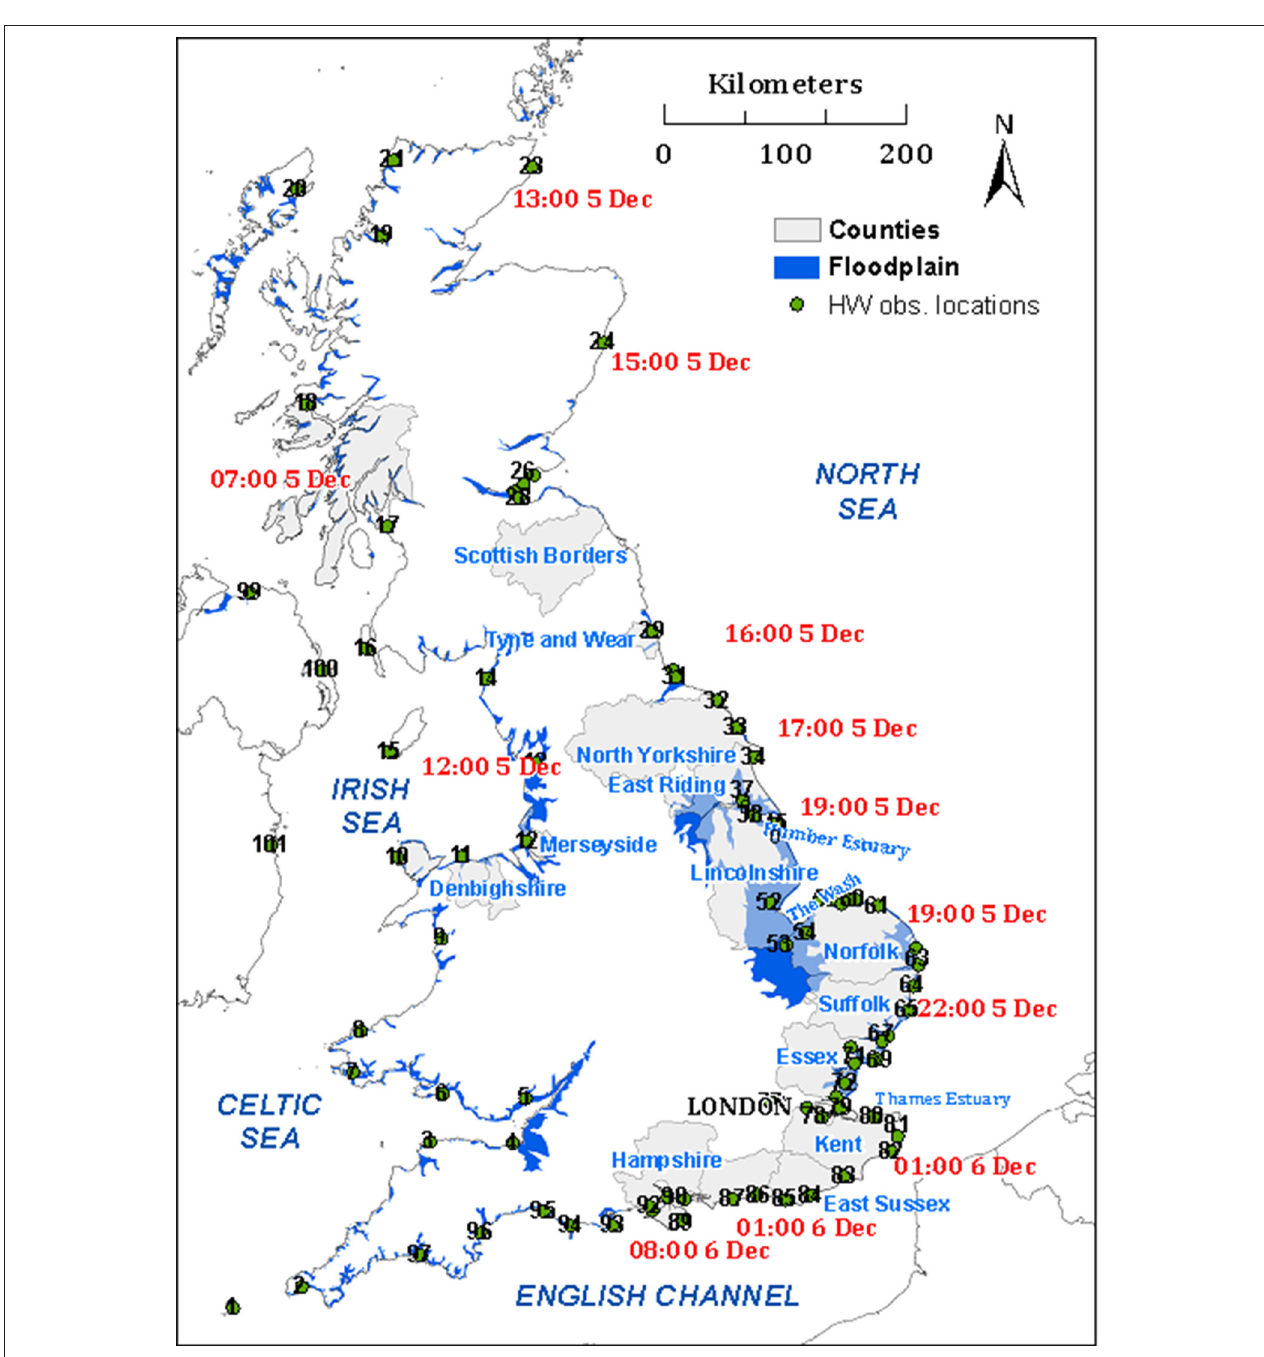
FIGURE 3 | Map of UK counties referred to throughout the paper. Also shown are the locations of HW recordings (refer to Table 2 for site names and data sources), and timings of HW during 5–6 December 2013 (which were similar to the timing of the HWs of 31 January-1 February 1953). The background blue shaded area is land surface that is below a static extreme water level (approximately 1 in 200 years), and which without defenses is theoretically susceptible to coastal inundation.